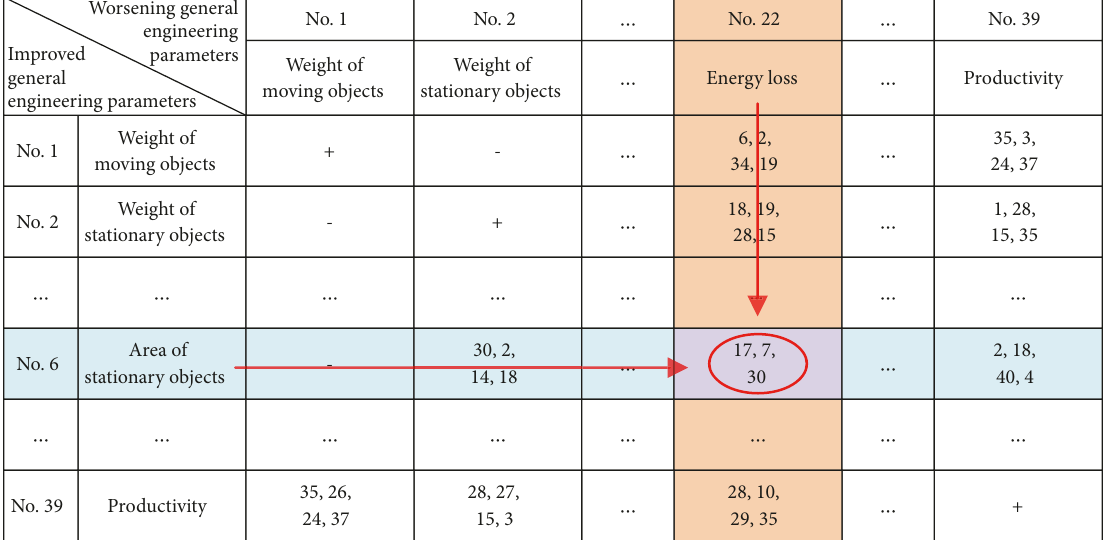
Figure 7: The contradiction matrix.